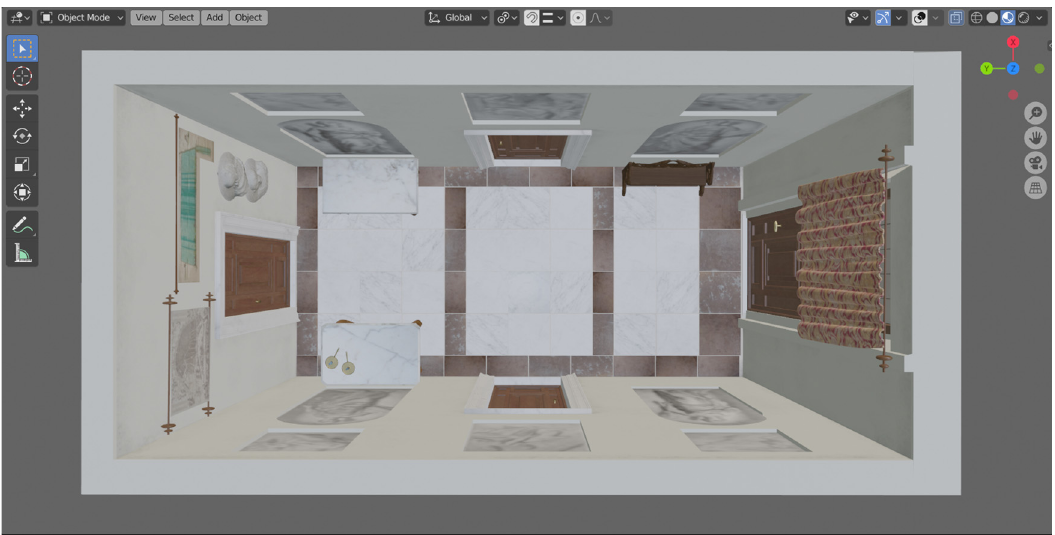
Figure 5: Top perspective view of the proposed reconstruction of De Grae ff ’ s voorhuis where the spatial relations between wall decorations, pieces of furniture, and fl oor patterns are